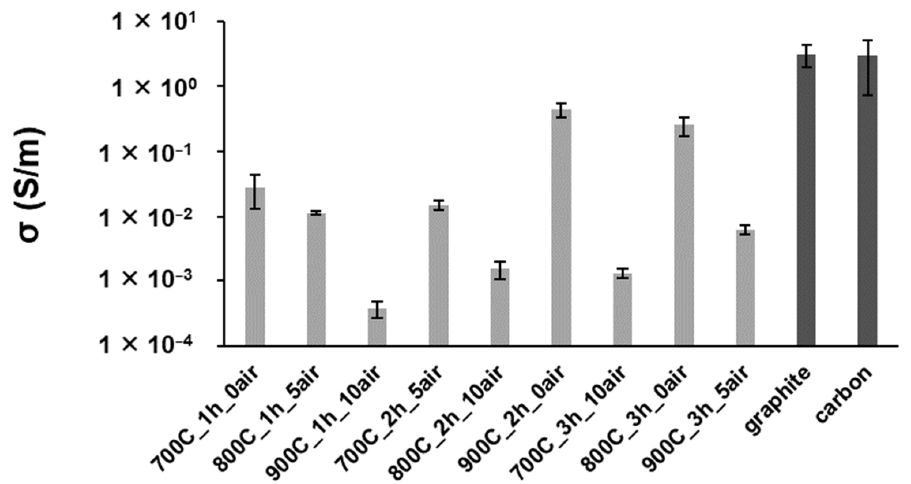
Figure 4. Electrical conductivity of biochar-sample pyrolysis with different time, temperature, and air-oxidation conditions (gray bars), with the graphite and carbon materials as reference (dark bars).